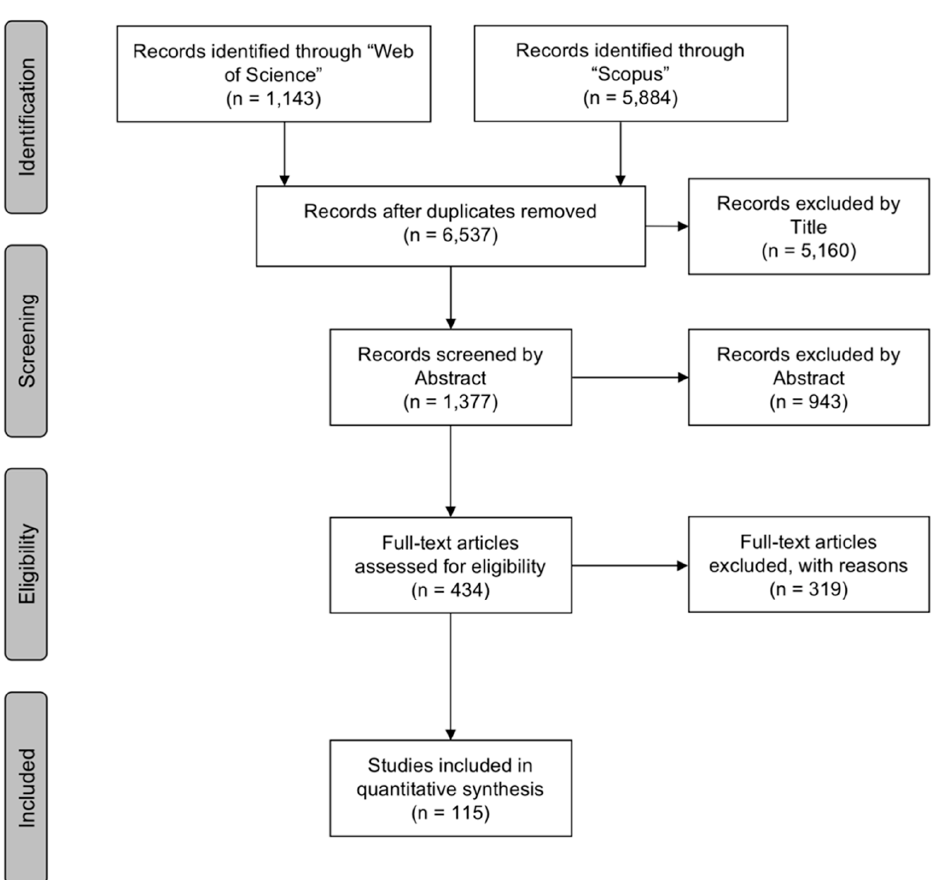
Figure 2. A “PRISMA” diagram showing the flow of information through the different phases of the review [50].